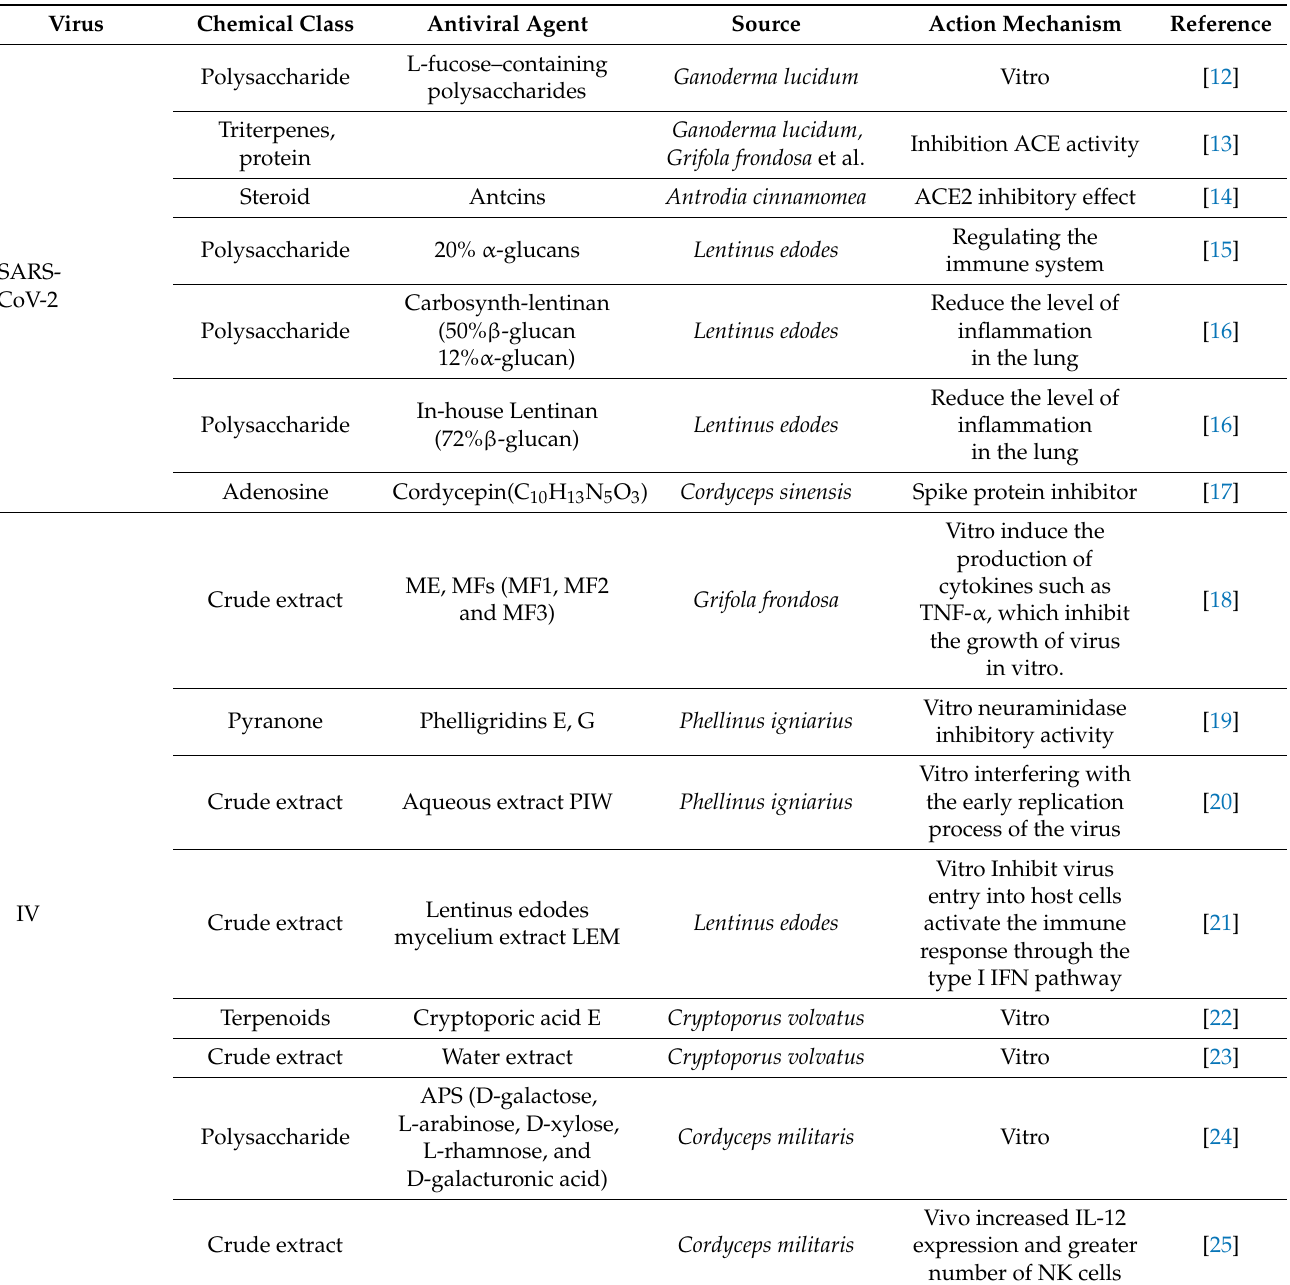
Table 1. Antiviral activities of medicinal fungi and their mechanism of action in human